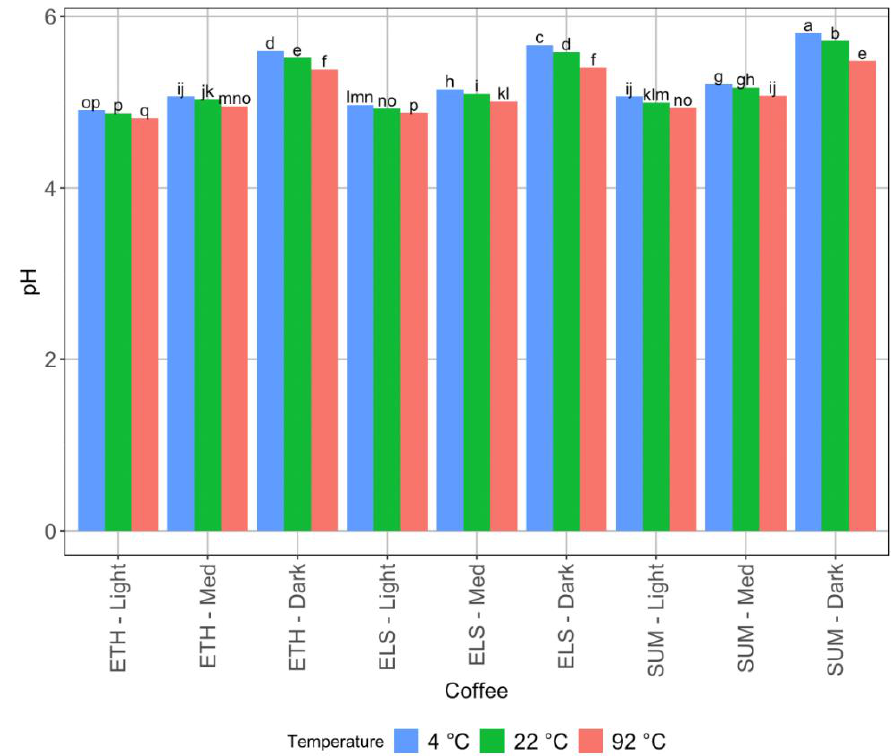
Figure 2. The mean pH value of all brews, with LSD letter codes to indicate significant difference. Codes refer to origin (Eth, ELS, and SUM as Ethiopia, El Salvador, and Sumatra respectively), roast (L, M, or D as light, medium, or dark respectively), and brew temperature (4 °C, 22 °C, and 92 °C).